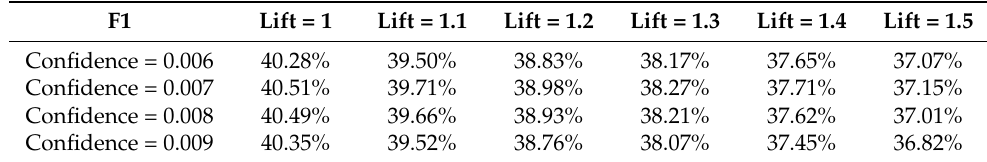
Table 4. The value of